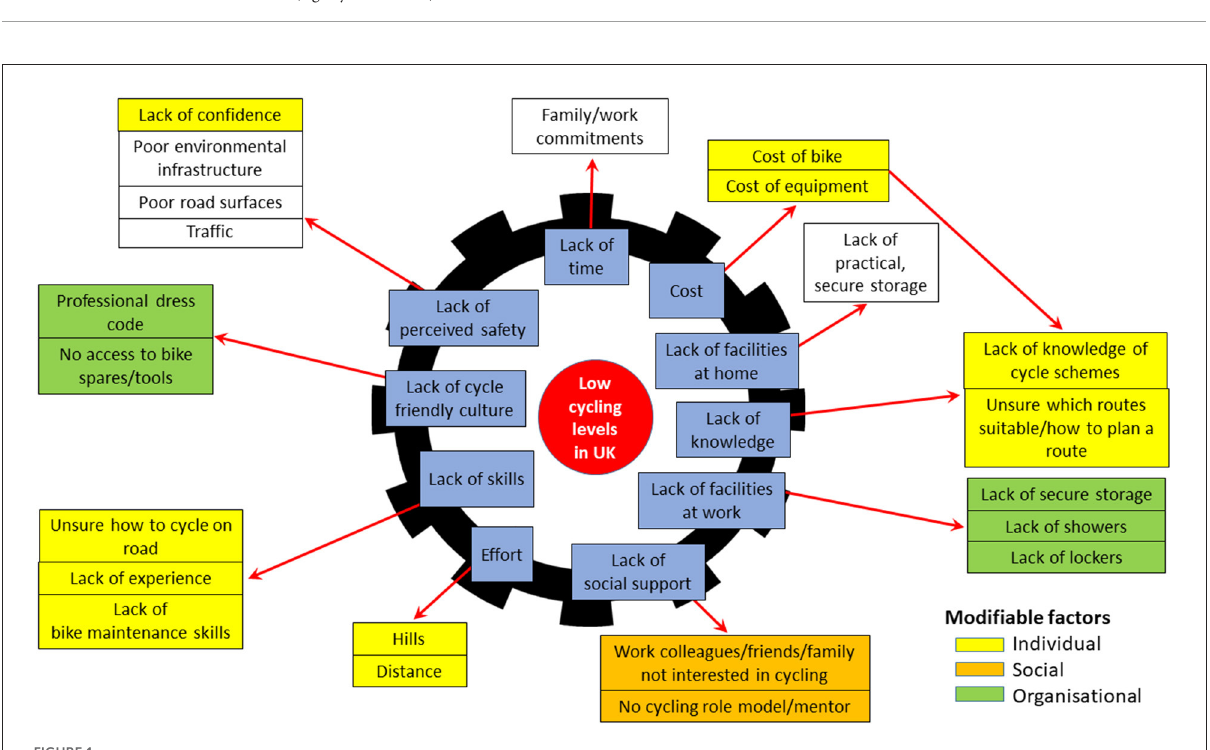
FIGURE1 Barriers to cycling (shown in blue) and associated modifiable factors at individual, social and organizational